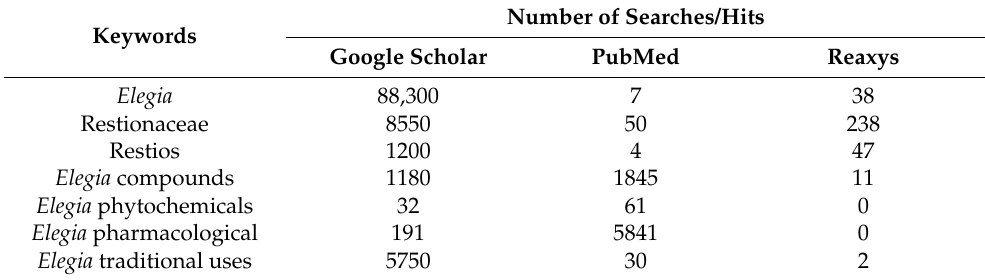
Table 1. The number of searches/hits for each